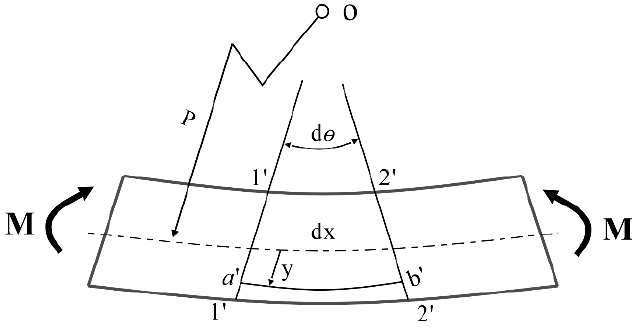
Figure 1. Schematic diagram of sensor geometric deformation.